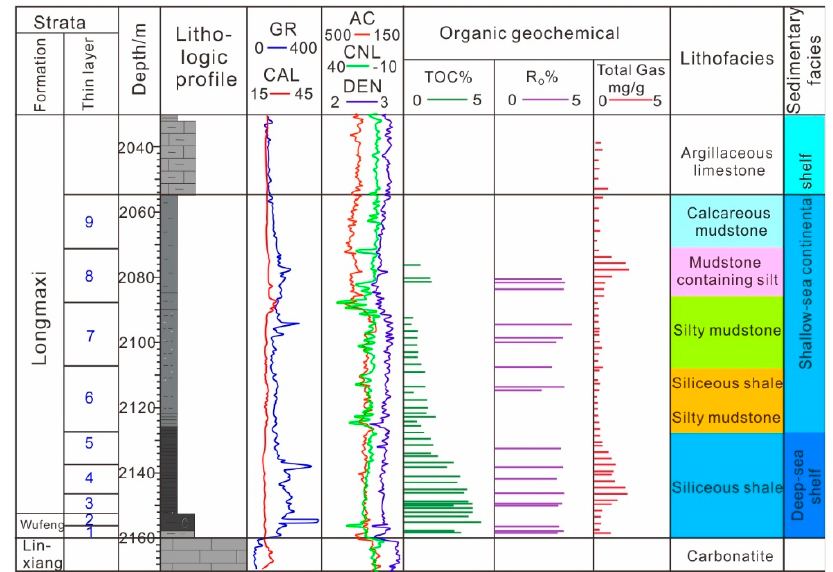
Figure 9. Lithologic profile and geochemical characteristics of PY1.